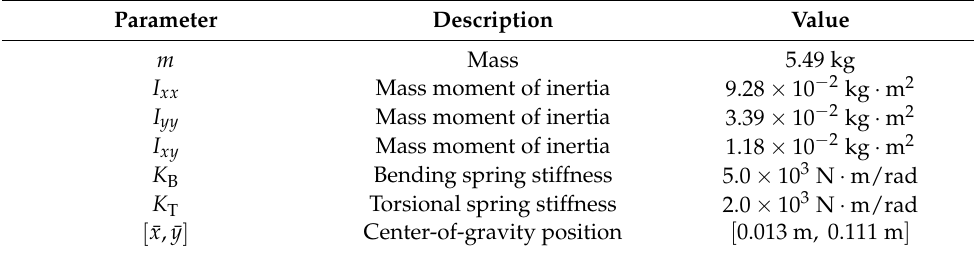
Table 1. Structure parameters of the all-movable